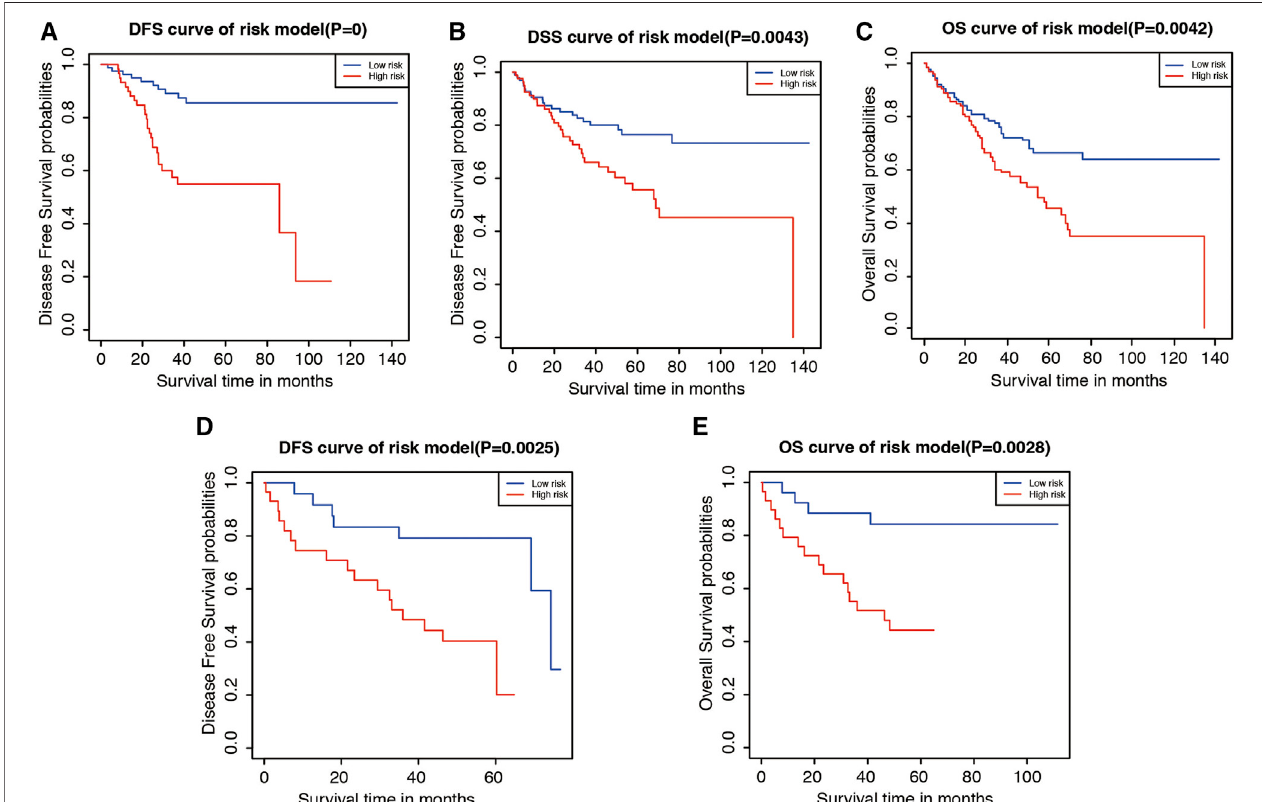
FIGURE8| ThevalidationofprognosticvalueofriskmodelinGSE17536 andGSE17537. (A – C) .Kaplan-Meierplotofdisease-freesurvival(DFS),diseasespeci fi c survival (DSS), and overall survival (OS) according to risk group for patients from GEO Series GSE17536. (D,E) . Kaplan-Meier plots of DSS and OS according to risk group for patients from GEO Series